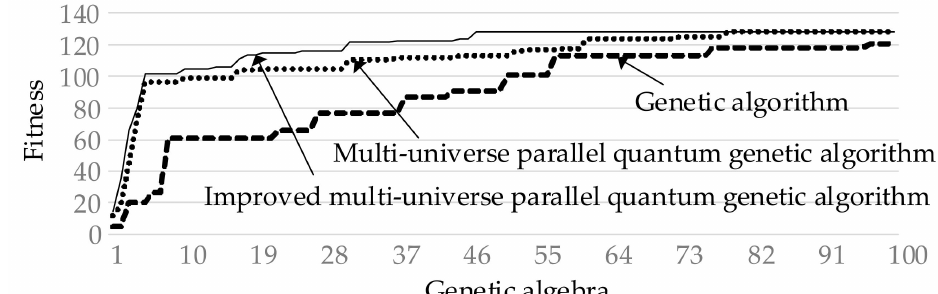
Figure 5. Algorithm performance